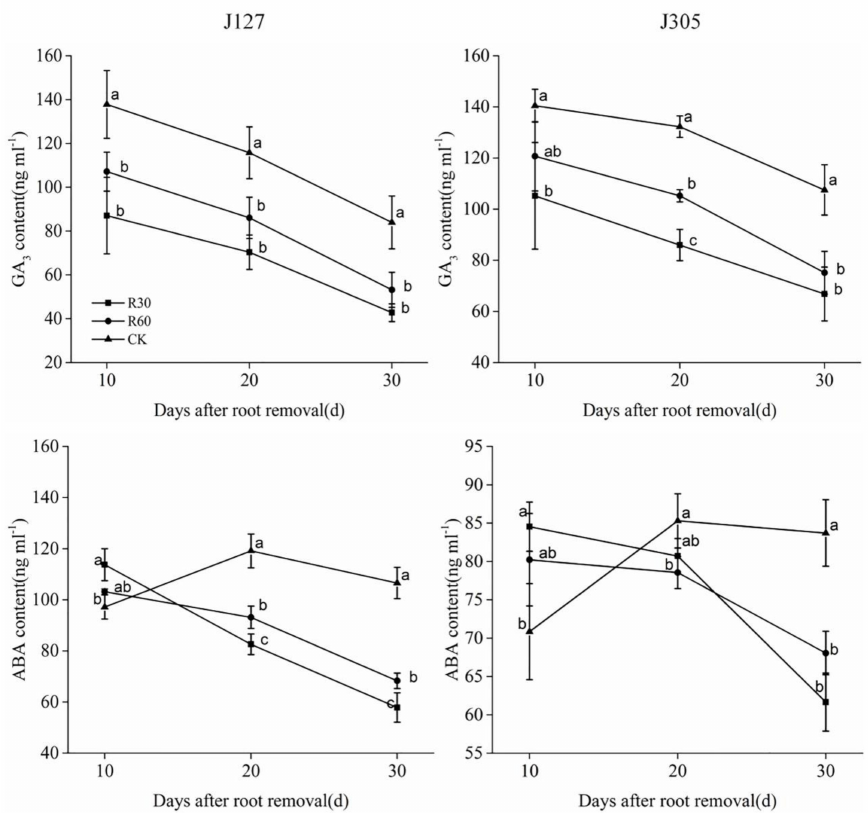
Figure 5. E ff ects of root removal in di ff erent soil depths on gibberellin (GA 3 ) content and abscisic acid (ABA) content in root bleeding sap. No roots removed, CK; roots removed at 30 cm underground,